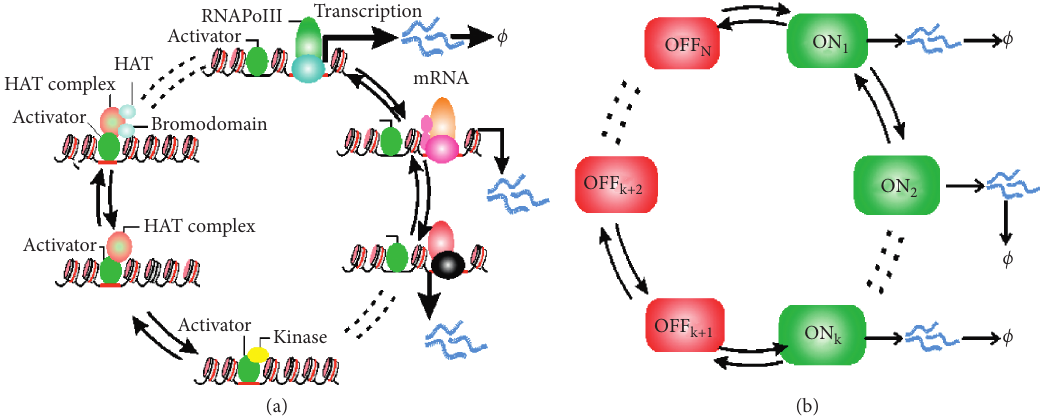
Figure 1: (a) Schematic diagram for a biological prototype of gene expression. Both the activation and deactivation of a gene are complex processes, possibly involving recruitments of transcription factors, complexes, and histones as well as some modifications. (b) The biological prototype in (a) is mapped into a theoretical model of gene expression, where ON and OFF represent transcriptional active and inactive states. In (a) and (b), arrow represents transition direction between two distinct